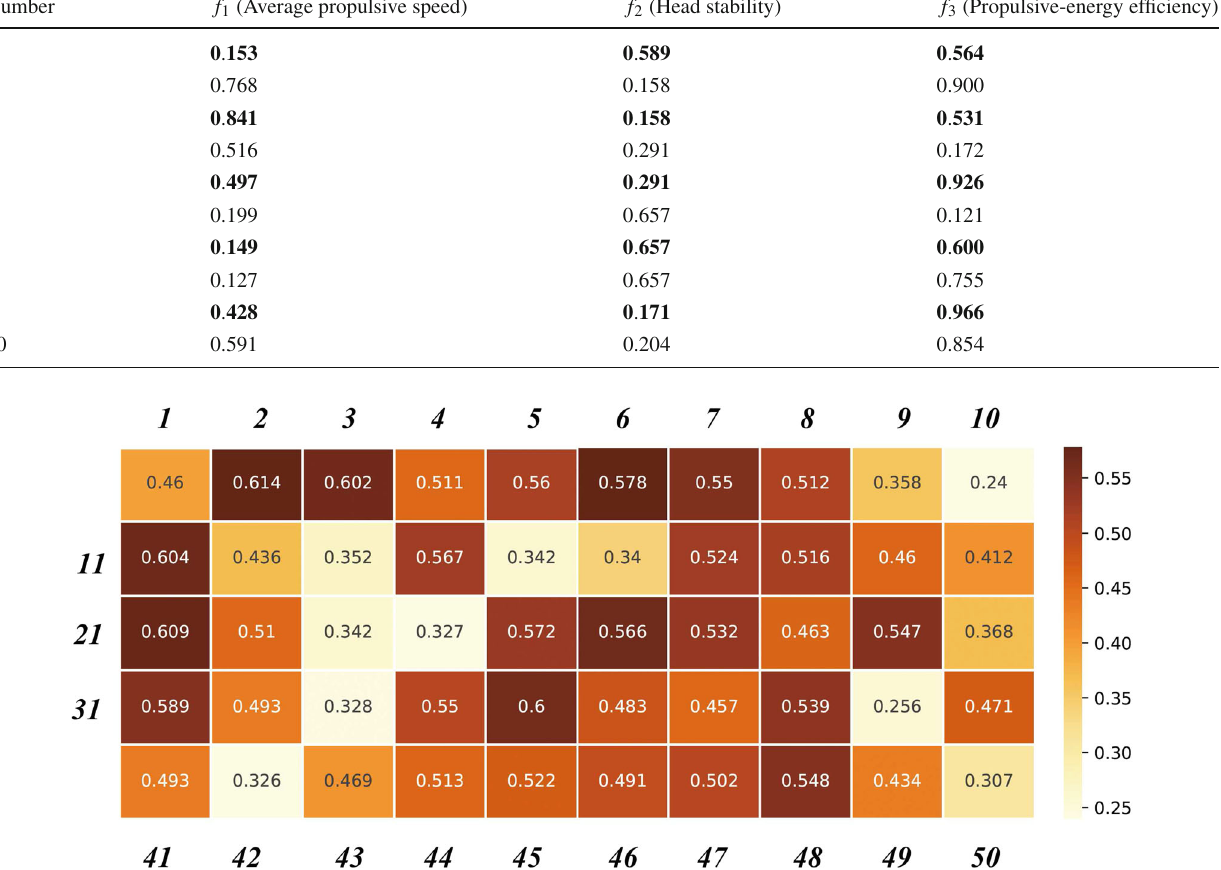
Fig. 10 The heat map graph of final fifty solutions values calculated using Eq.